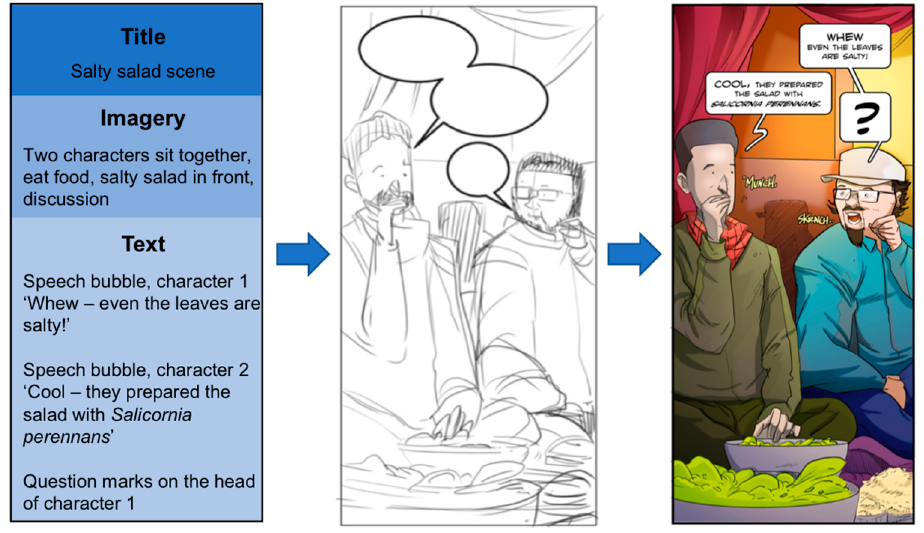
Figure 6. Exemplary page evolvement from detailed storyboard to sketch to final artwork.